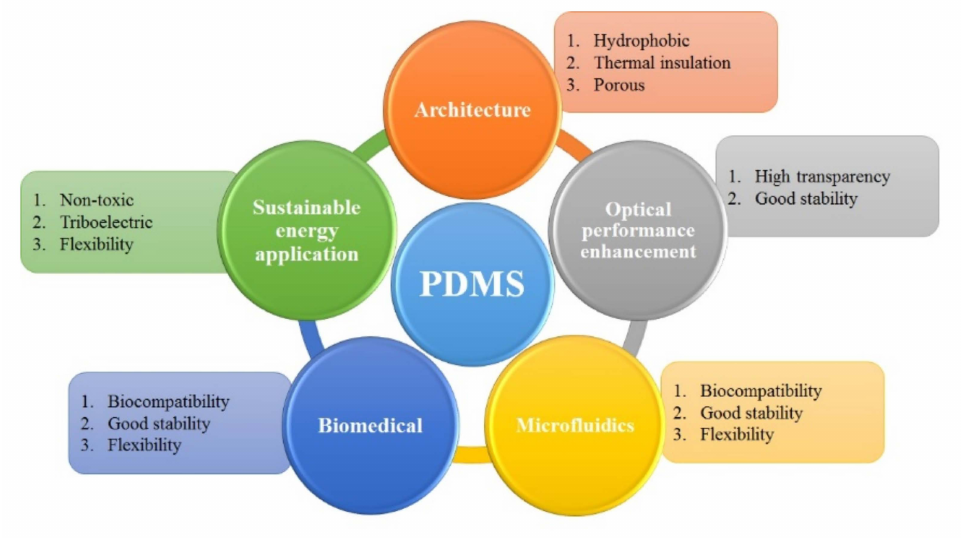
Figure 1. The PDMS applications corresponding to its